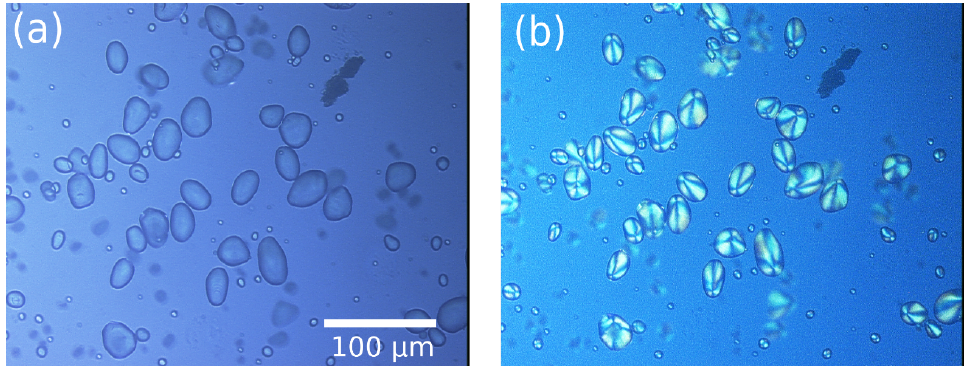
Figure 2. 732 × 546 pixel images of starch granules from potato using a Leica microscope customized with tri-CCD Sony camera and Sarfus software. ( a ) White lamp wide-field image and ( b ) crossed polarization-resolved